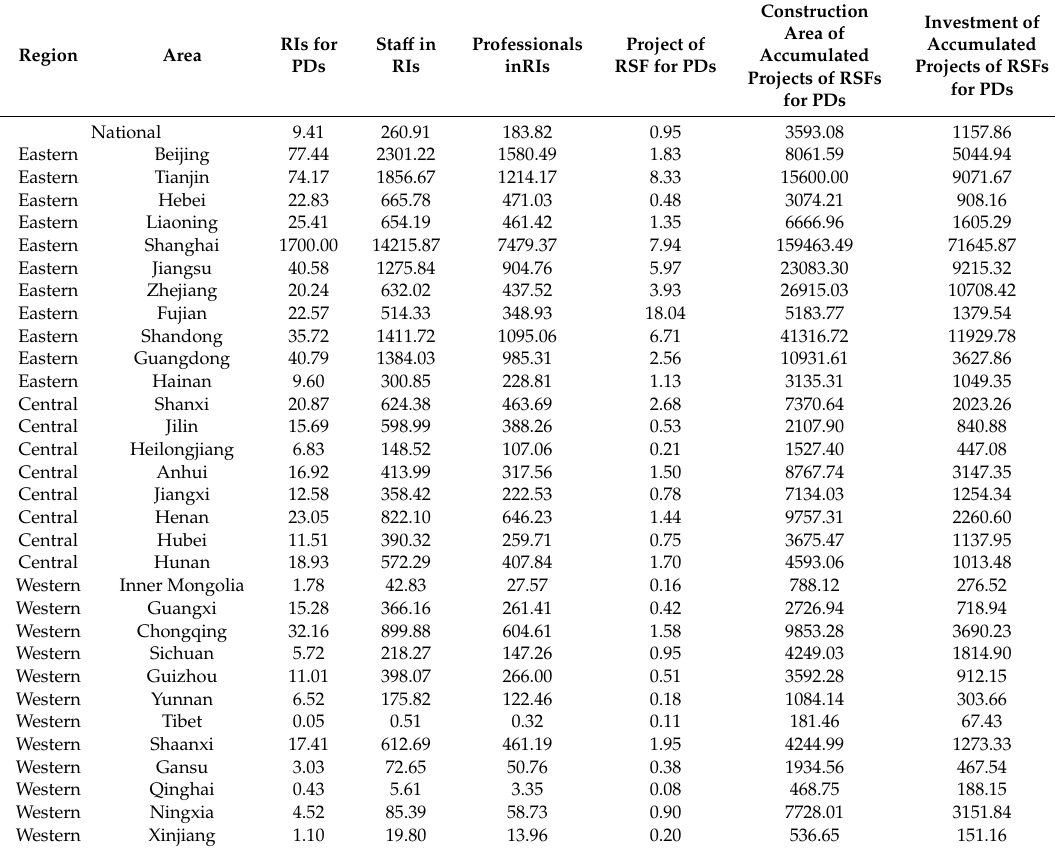
Table 3. Regional distribution per 10,000 km 2 of rehabilitation resources for PDs in China in 2018.